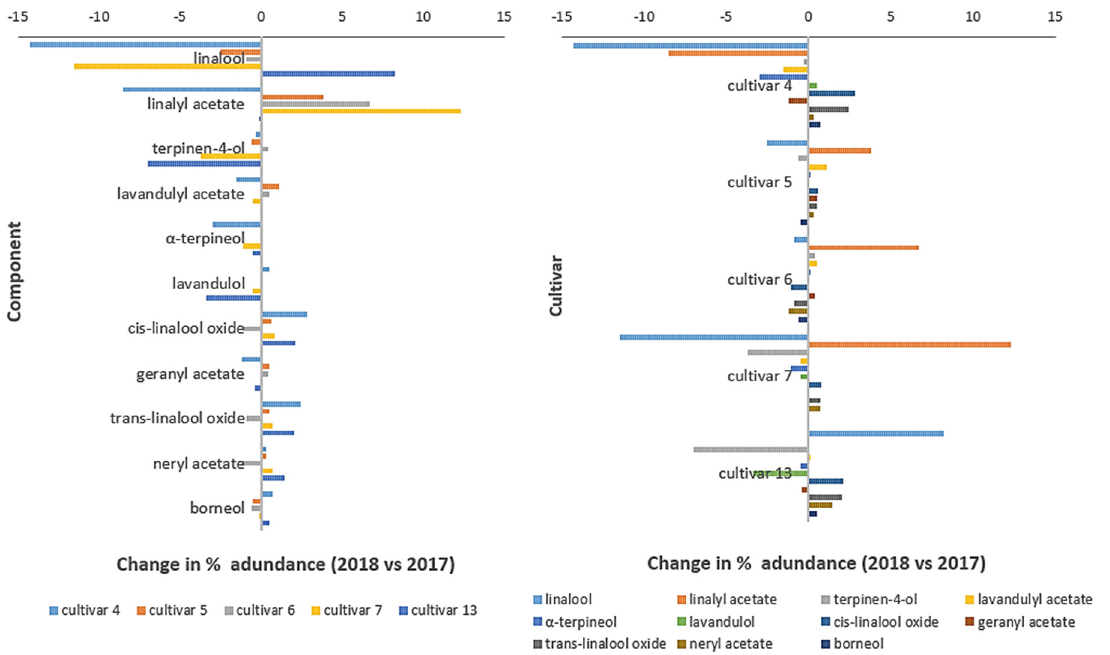
Figure 4. Inter-year (2018 vs. 2017) changes of relative % abundancies of the main oil components cropped from the different studied lavender cultivars. The left plot highlights changes for oil components and the right plot highlights changes for cultivars.